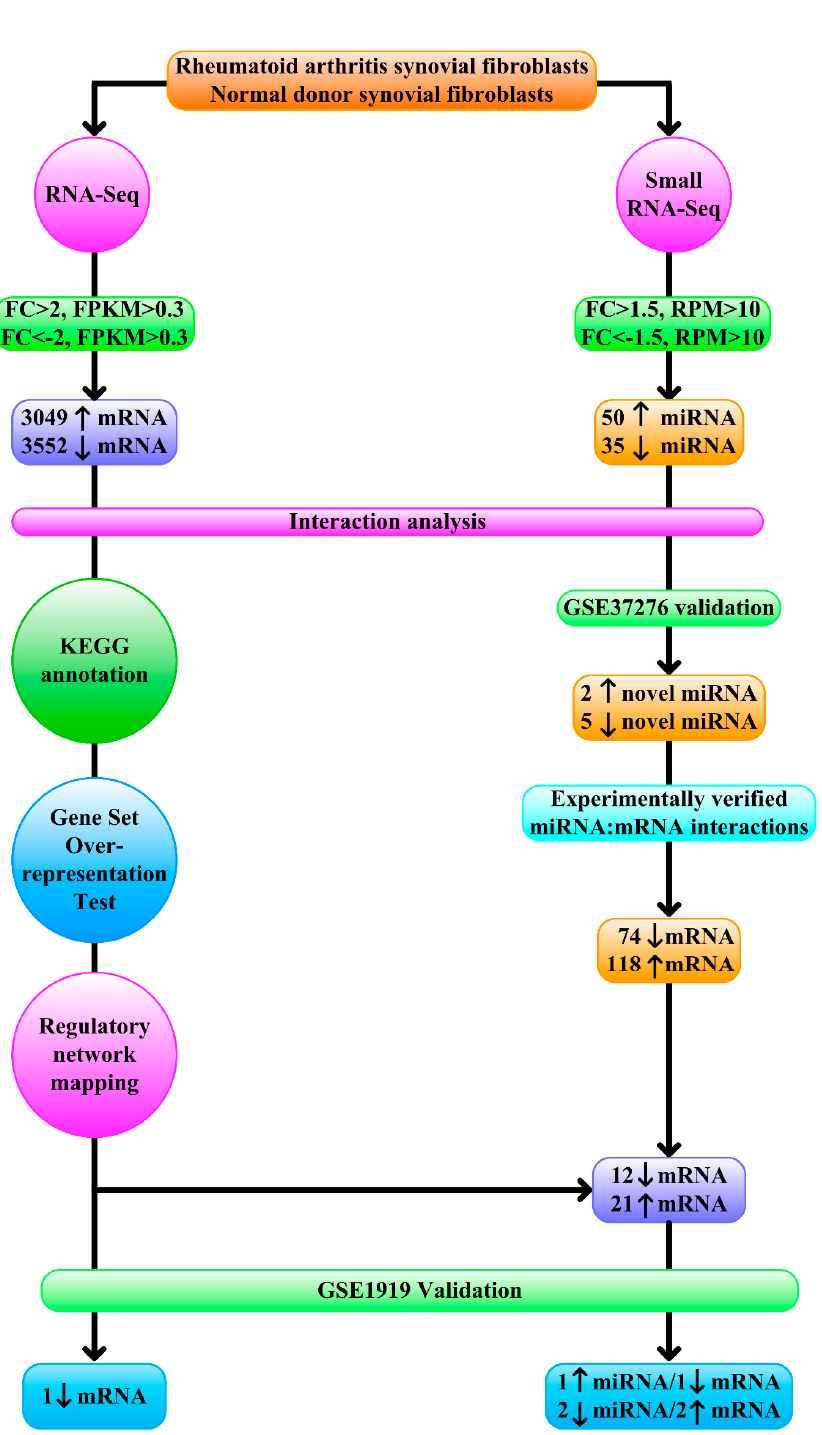
Figure 1. Schematic representation of the next-generation sequencing data analytical workflow. 3049 upregulated (fold change > 2, Fragments Per Kilobase of transcript per Million (FPKM) > 0.3), 3552 downregulated protein-coding mRNA (fold change < − 2, FPKM > 0.3), 50 upregulated (fold change > 1.5, Reads Per Million (RPM) > 10), and 35 downregulated (fold change < − 1.5, RPM > 10) miRNA were examined with interaction analysis. Kyoto Encyclopedia of Genes and Genomes (KEGG) annotation, Gene Set Overrepresentation Test, regulatory network mapping, and mRNA validation with GSE1919 identified one downregulated mRNA as master regulator. Seven novel miRNAs were also verified with GSE37276. Of 74 downregulated and 118 upregulated mRNA as experimentally verified targets of validated novel miRNA, 12 and 21 displayed concordant changes in RNA-seq, and one downregulated and two upregulated mRNA were validated with